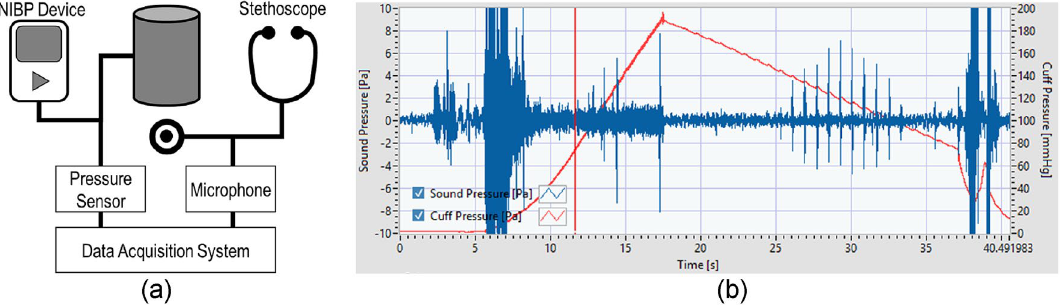
Figure 1. Blood pressure data collection system using a stethoscope and data acquisition board: ( a ) data acquisition system and stethoscope connected to a microphone, and ( b ) LabVIEW-based data acquisition